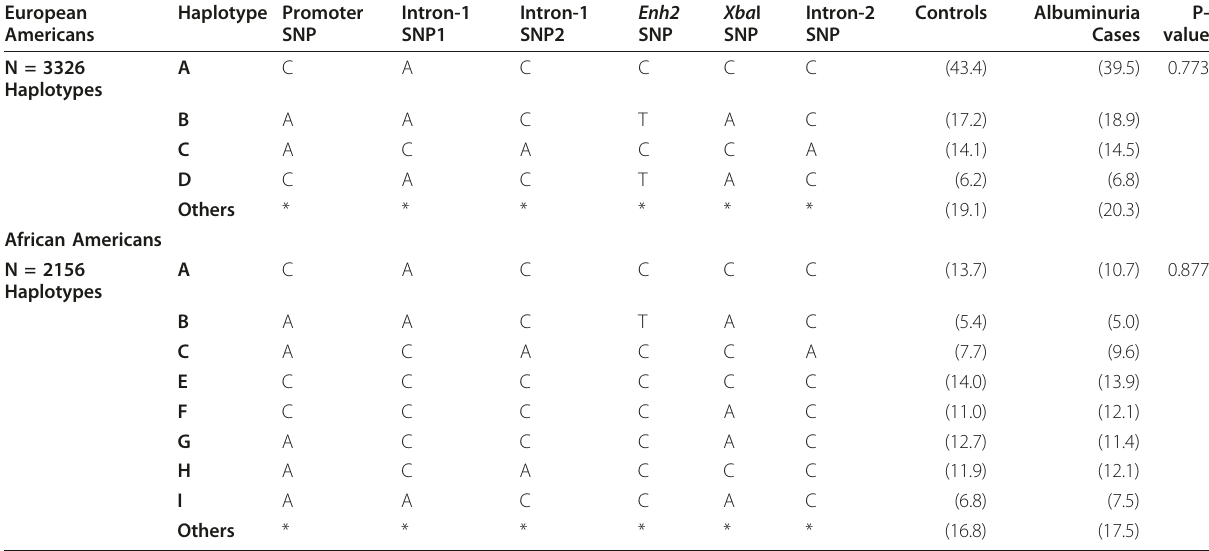
Table 3 Major Haplotype Distribution in Case and Control Subjects by Race in stage 1 †‡ European